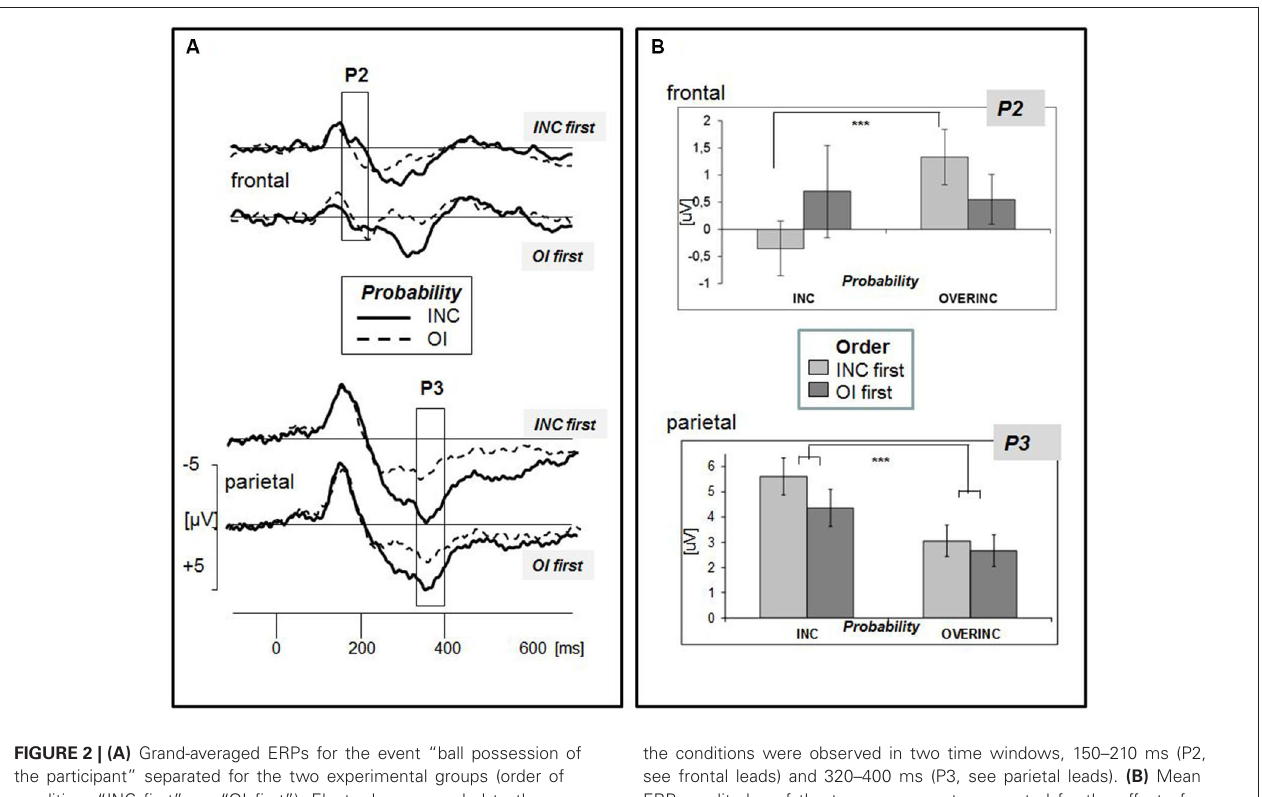
FIGURE 2 | (A) Grand-averaged ERPs for the event “ball possession of the participant” separated for the two experimental groups (order of condition: “INC first” vs. “OI first”). Electrodes are pooled to the clusters “frontal” and “parietal”. Two experimental conditions related to different probabilities of ball possession are superimposed (INC: inclusion, 33%; OI: overinclusion, 46%). Amplitude differences between